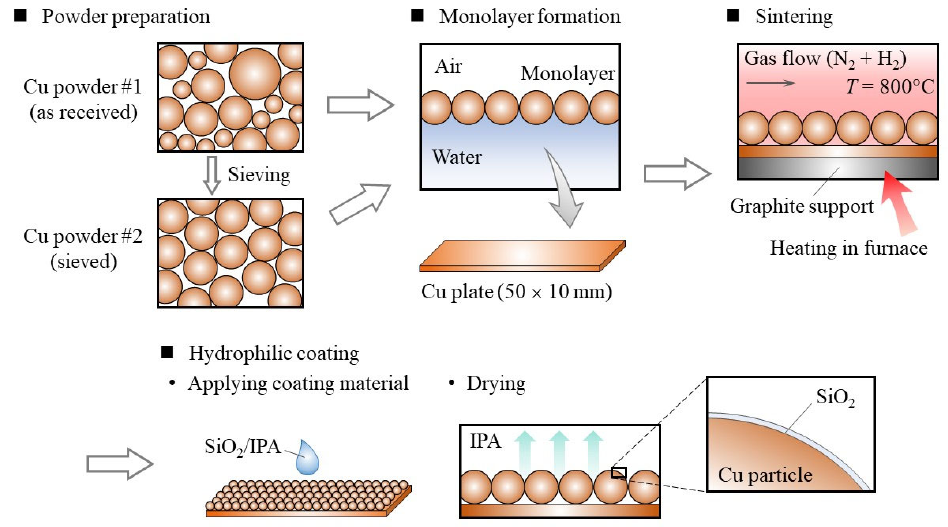
Figure 1. Schematic of sample preparation process.